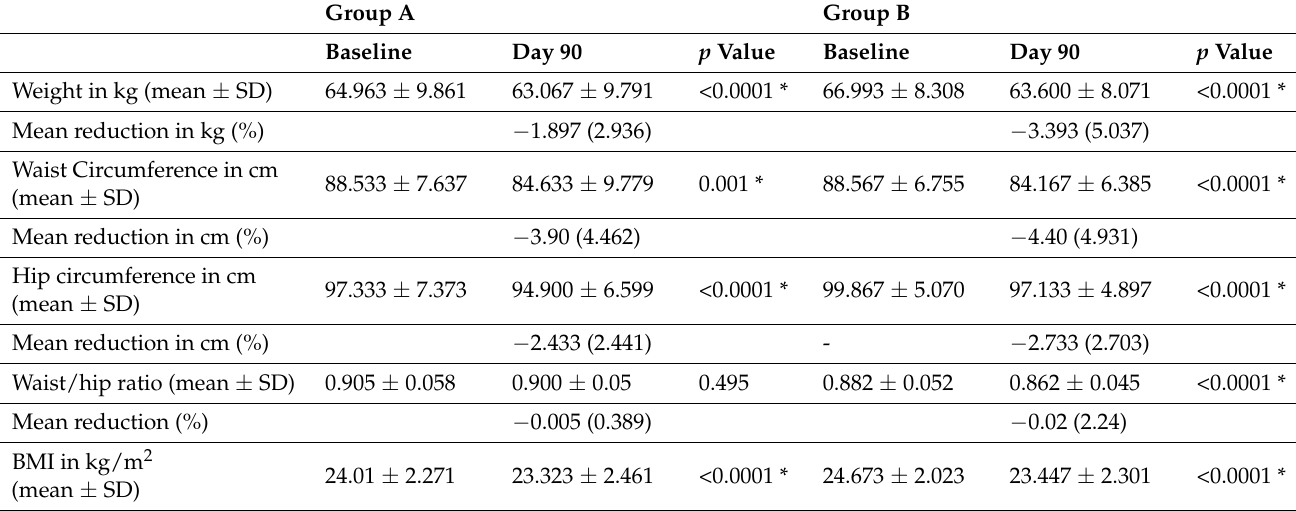
Table 2. Change in weight, waist circumference (cm), hip circumference (cm), and waist/hip ratio within the group at 90